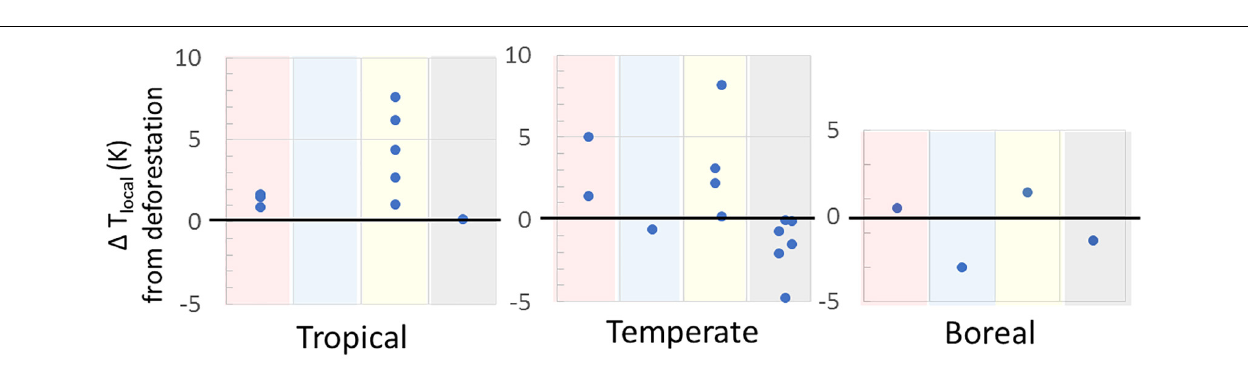
FIGURE 2 | Local average annual temperature change in response to deforestation (black symbols) or afforestation (green symbols) as determined by comparing neighboring forested and open land (space for time approach) or measuring forest change over time in the tropics, temperate and boreal zones, by (A) in situ or (B) satellite based land surface temperature measurements (0 m, triangles) or air temperature measurements (2 m, circles). See Supplementary Information 2 for data sources.